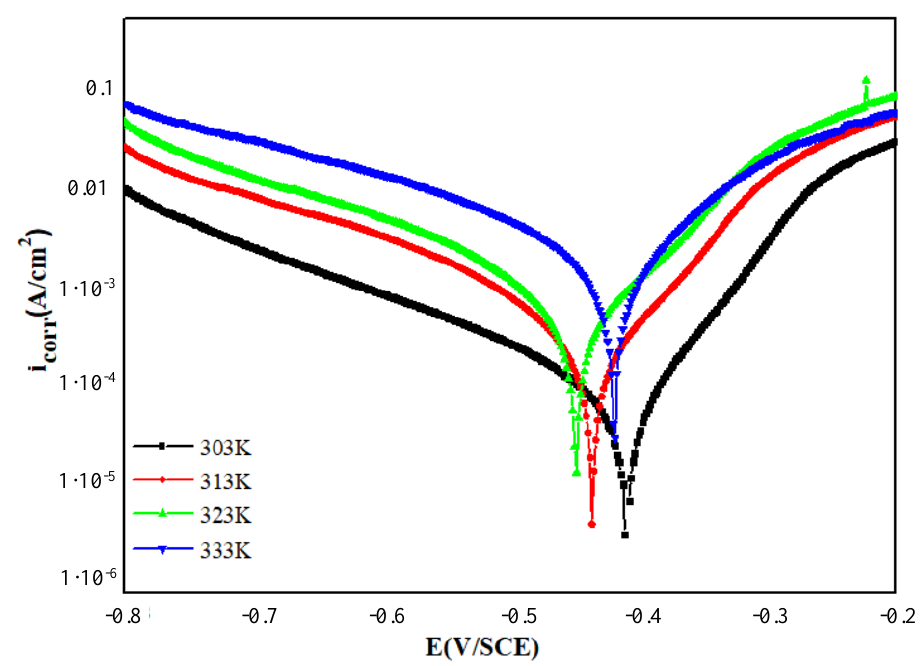
Figure 2. Polarization curves for (MS) in 1 M HCl with different concentrations of PPD at 303 K. The Tafel extrapolation treatment was used to obtain estimates of electrochemical parameters such as corrosion current density ( i corr ), corrosion potential ( E corr ), Tafel